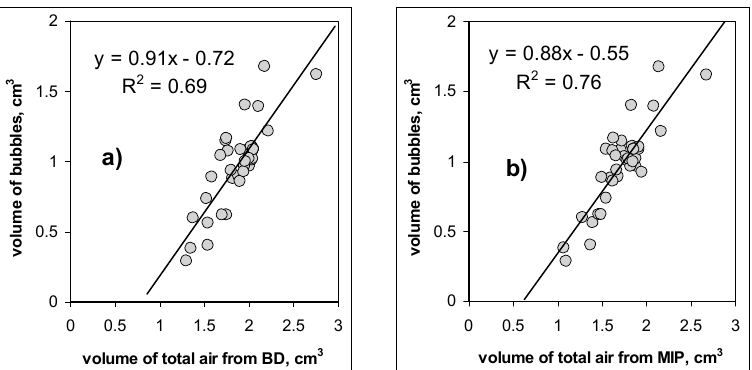
Figure 10. Relations of the total volume of bubbles and total volume of air present in the aggregates: ( a ) calculated from bulk density and ( b ) measured by mercury intrusion